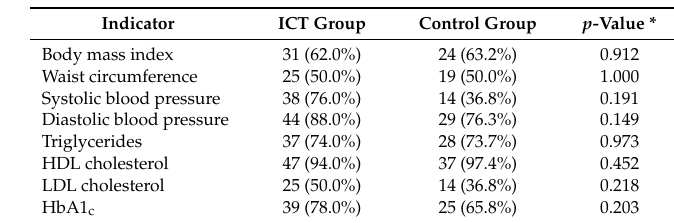
Table 4. Comparing the indicators for the ICT and control groups for whom the program was judged to be e ff ective or where they maintained